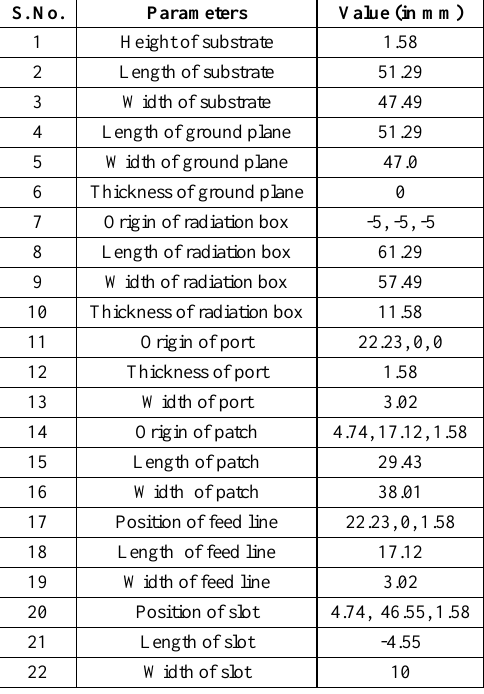
Table 2. Dimension of final